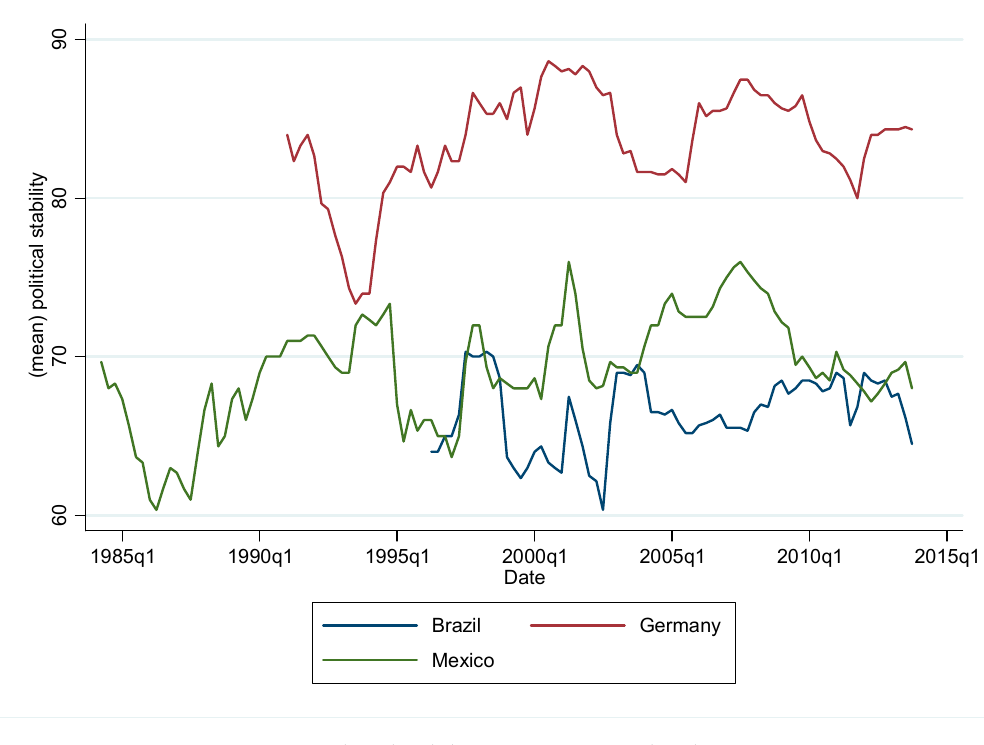
Figure A2. Political stability: Germany, Brazil and Mexico.